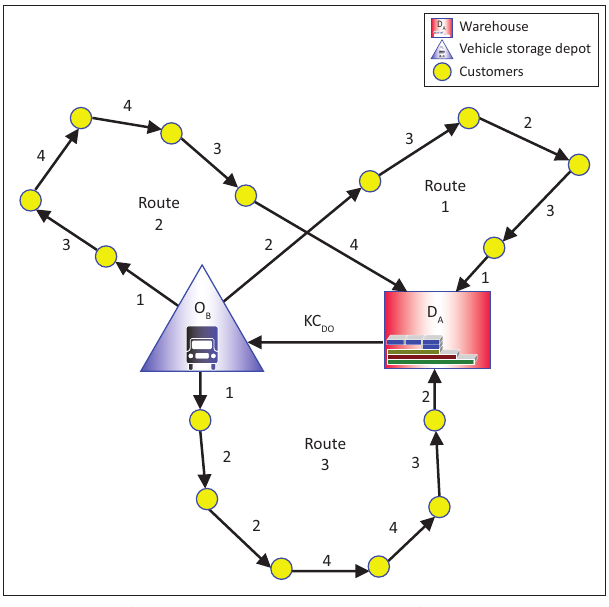
FIGURE 2: Example of the Capacitated Vehicle Routing Problem for Carriers with three routes, served by three vehicles of the